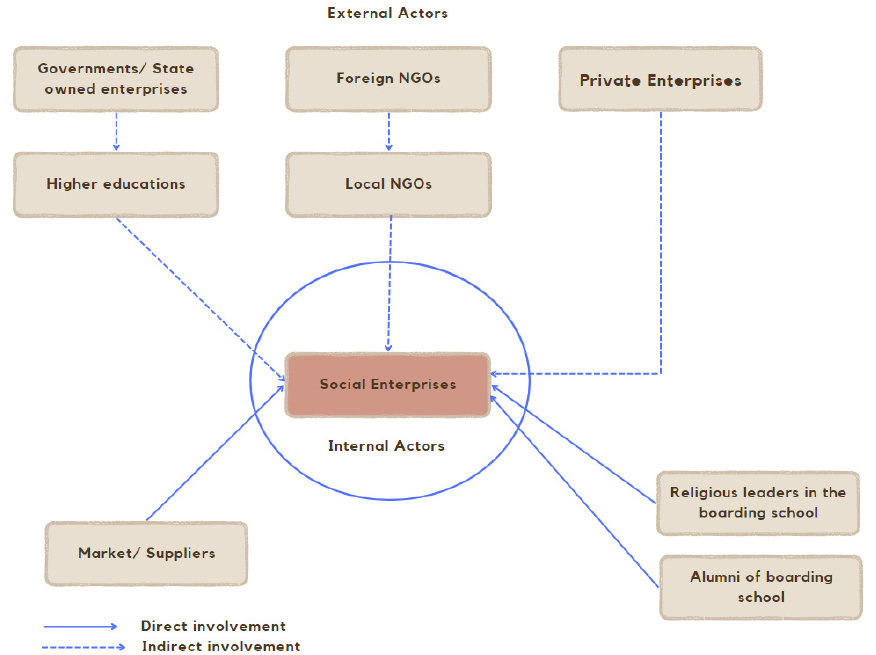
Figure 2. OI mechanism in social enterprises embedded in pesantren. Source: Authors’ elaboration